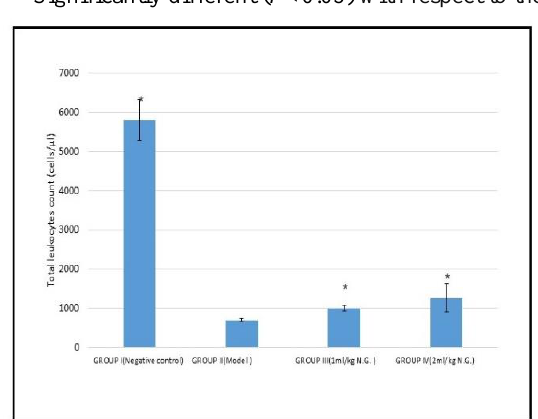
Figure 1. Bar chart showing total leukocytes count in various experimental mice groups.